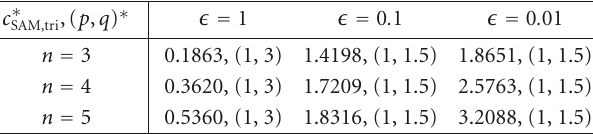
Figure 3: A network on the triangular grid with the spacing d tri meters between two adjacent nodes. Under the SAM, data pack- ets are transmitted from the black nodes to their neighboring gray nodes during a time slot. The horizontal spacing between two ac- tive transceivers is qd tri and the vertical spacing between two active √ 3 pd tri . transceivers is Table 3: The ( p , q )-optimal throughput in bits-hops/s/Hz/node of a network on the triangular grid under the SAM and nonfading